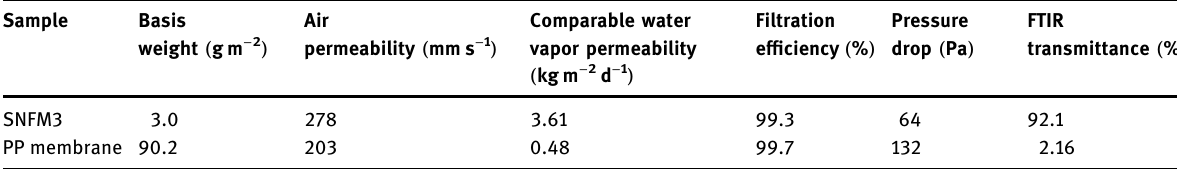
Table A1: Comparison of the relevant properties of multilayer structured SNFM3 and commercial PP membranes